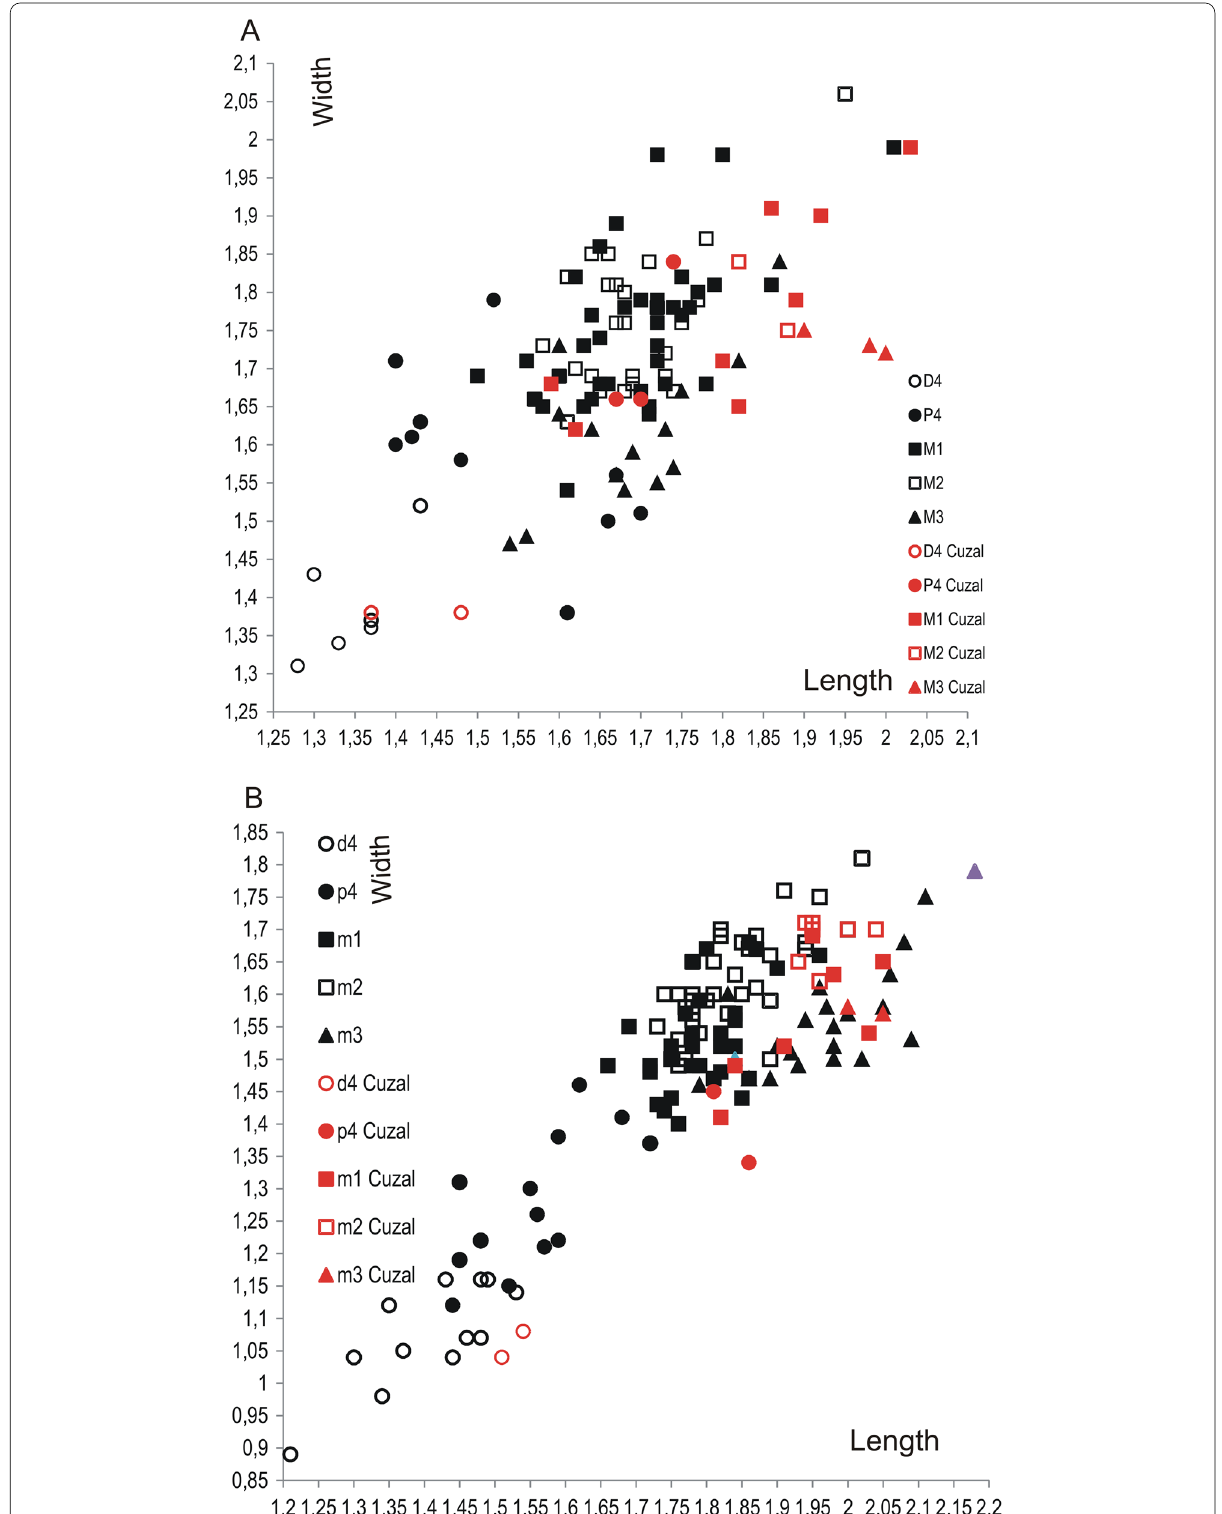
Fig. 41 Bivariate graph (width/length) of the size of the upper (A) and lower (B) teeth of ? Protadelomys alsaticus Hartenberger, 1969 from Cuzal (Quercy) (red marks) compared to the size of the teeth of ? Protadelomys alsaticus Hartenberger, 1969 from Bouxwiller (Bas‑Rhin) (black